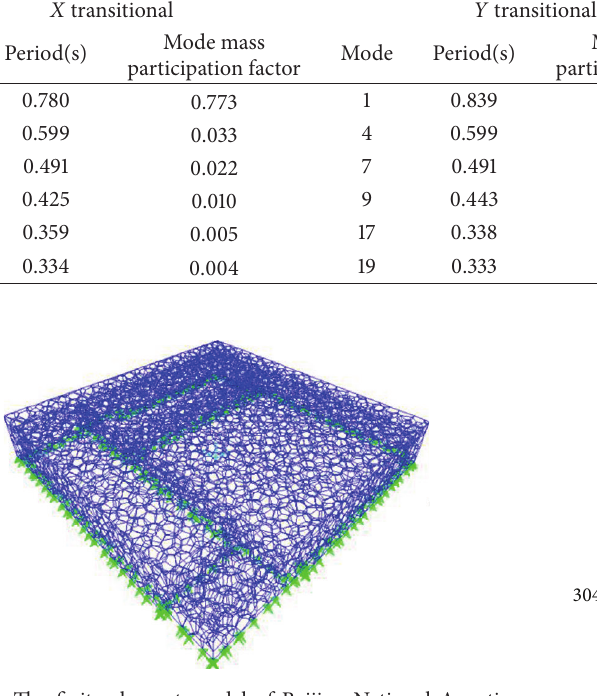
Figure 1: The finite element model of Beijing National Aquatics Center.